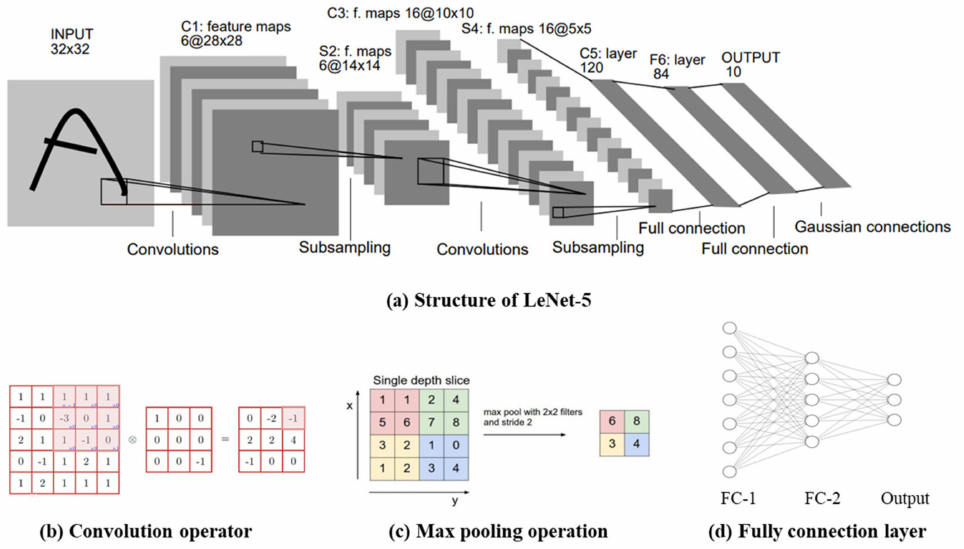
Figure 7. ( a ) An illustration of the LeNet − 5 and its three hierarchical structures: ( b ) convolutional layer, ( c ) pooling layer and ( d ) fully connected